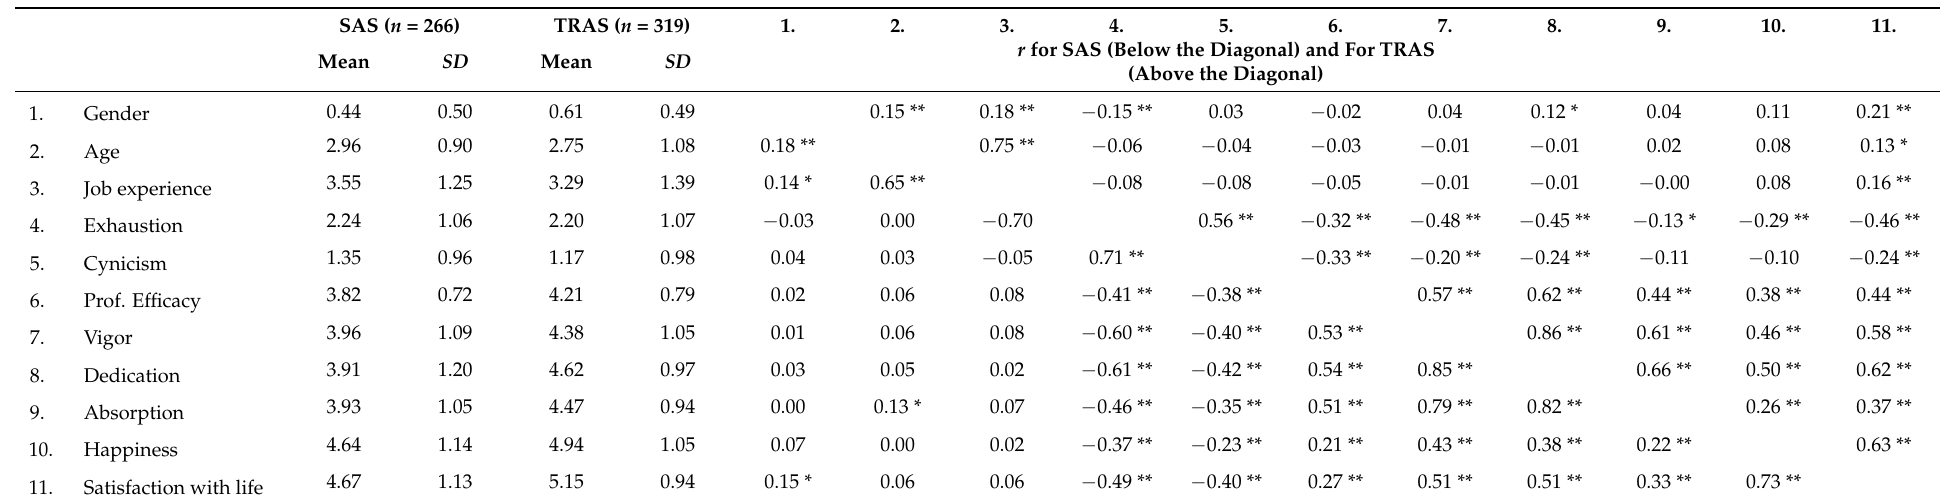
Table 2. Means, standard deviations and correlations between